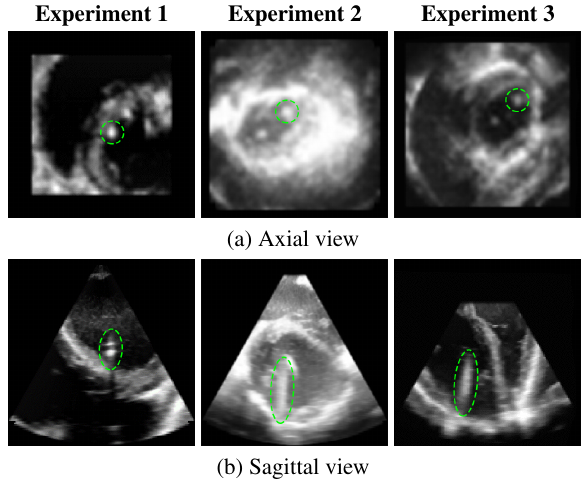
Figure 1. Examples of the source three-dimensional dataset with a catheter inserted into the left ventricle cavity Experiment 1